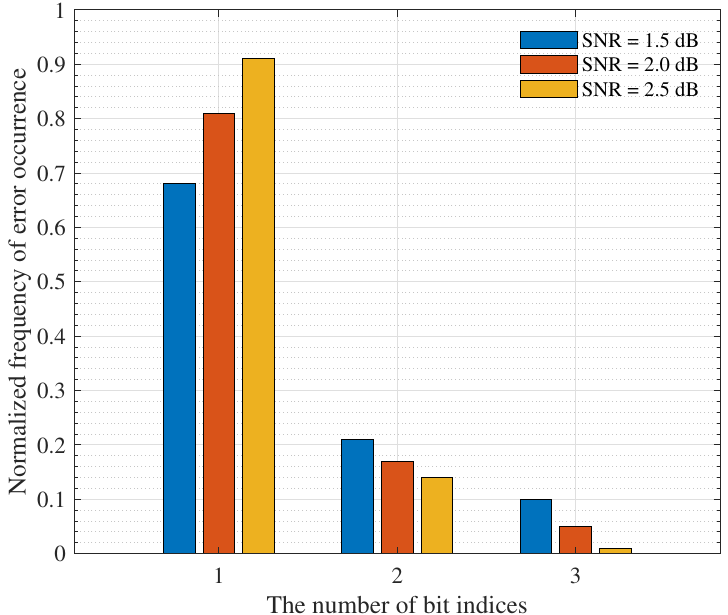
Figure 3. Channel-induced error occurrence frequencies under various SNR regions for P ( 512,256 )